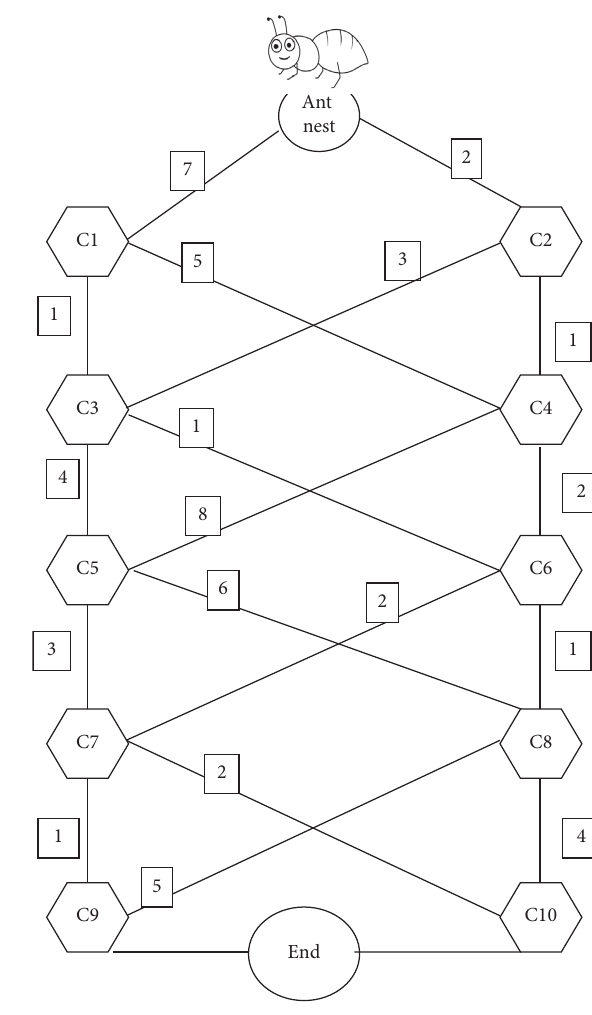
Figure 3: Pheromones excreted by ants on